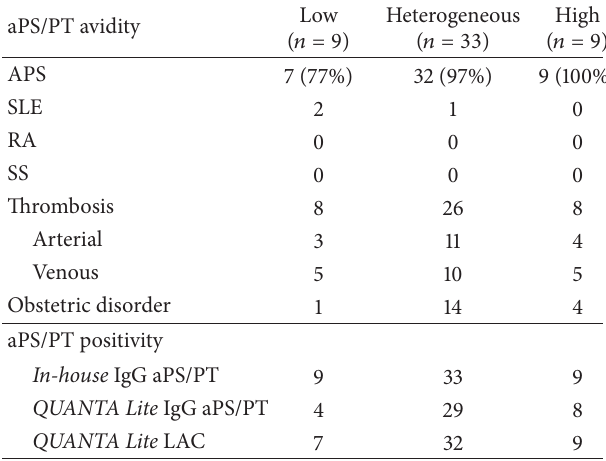
Table 4: Association of aPS/PT avidity with clinical features of autoimmune